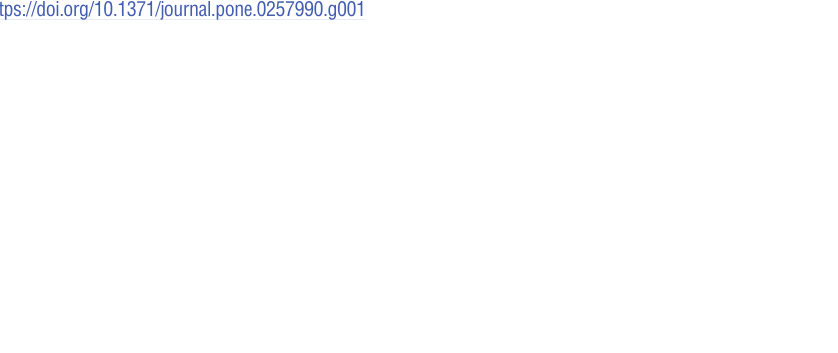
PLOS ONE | https://doi.org/10.1371/journal.pone.0257990 September 23,